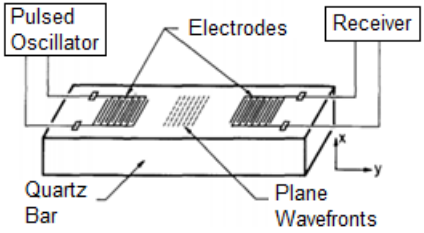
Figure 1. The first illustration of the arrangement for surface wave transduction using IDT on quartz substrate by White and Voltmer. Images reproduced with permission from references [9].